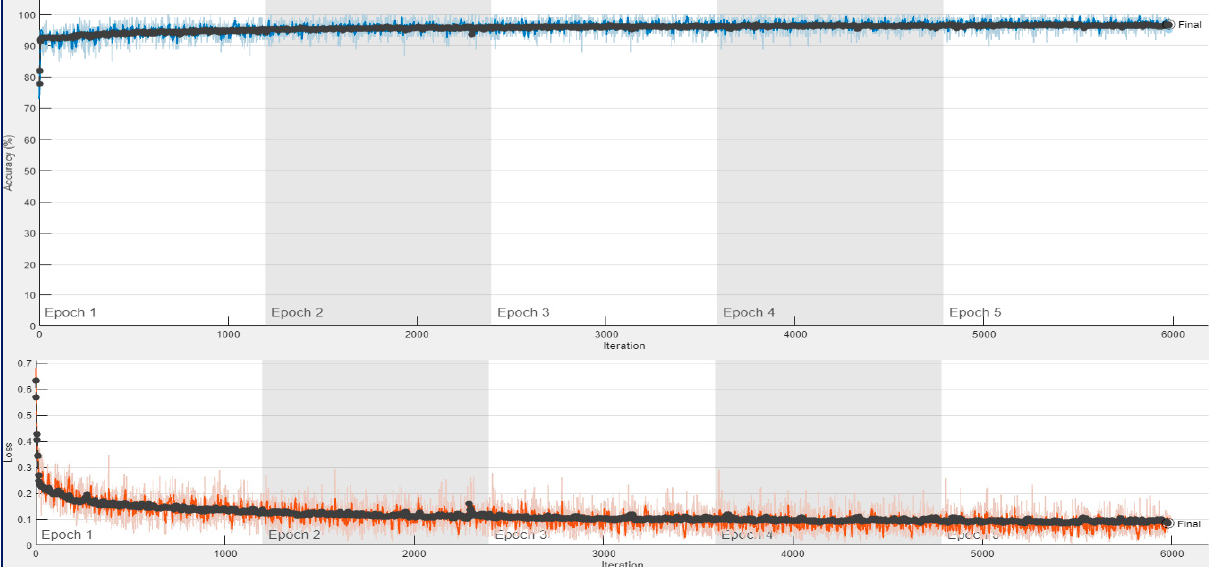
Figure 15. Training process result for ConvMixer with 132,968 spectrogram images in a trial on the